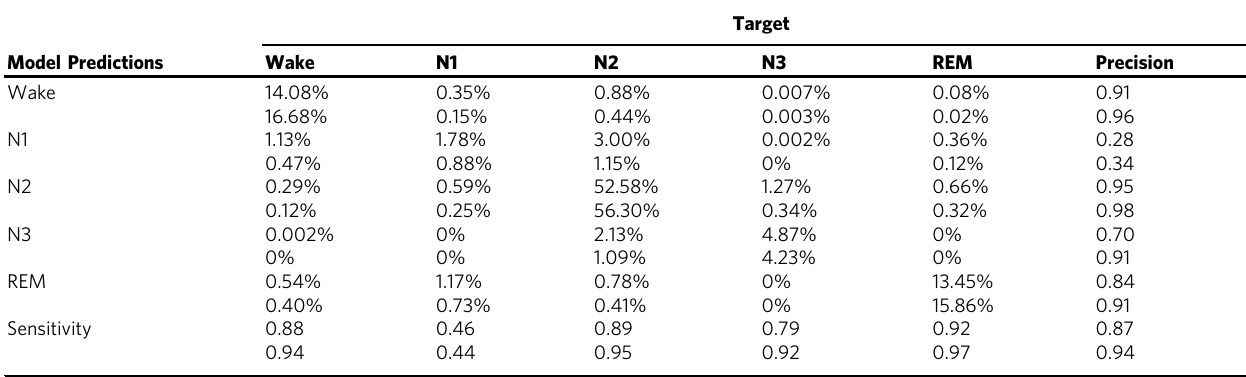
The targets are: top row: unweighted consensus; bottom row: weighted by the scorer agreement at each epoch. The number of analyzed epochs were 53,009 (unweighted) and 36,032